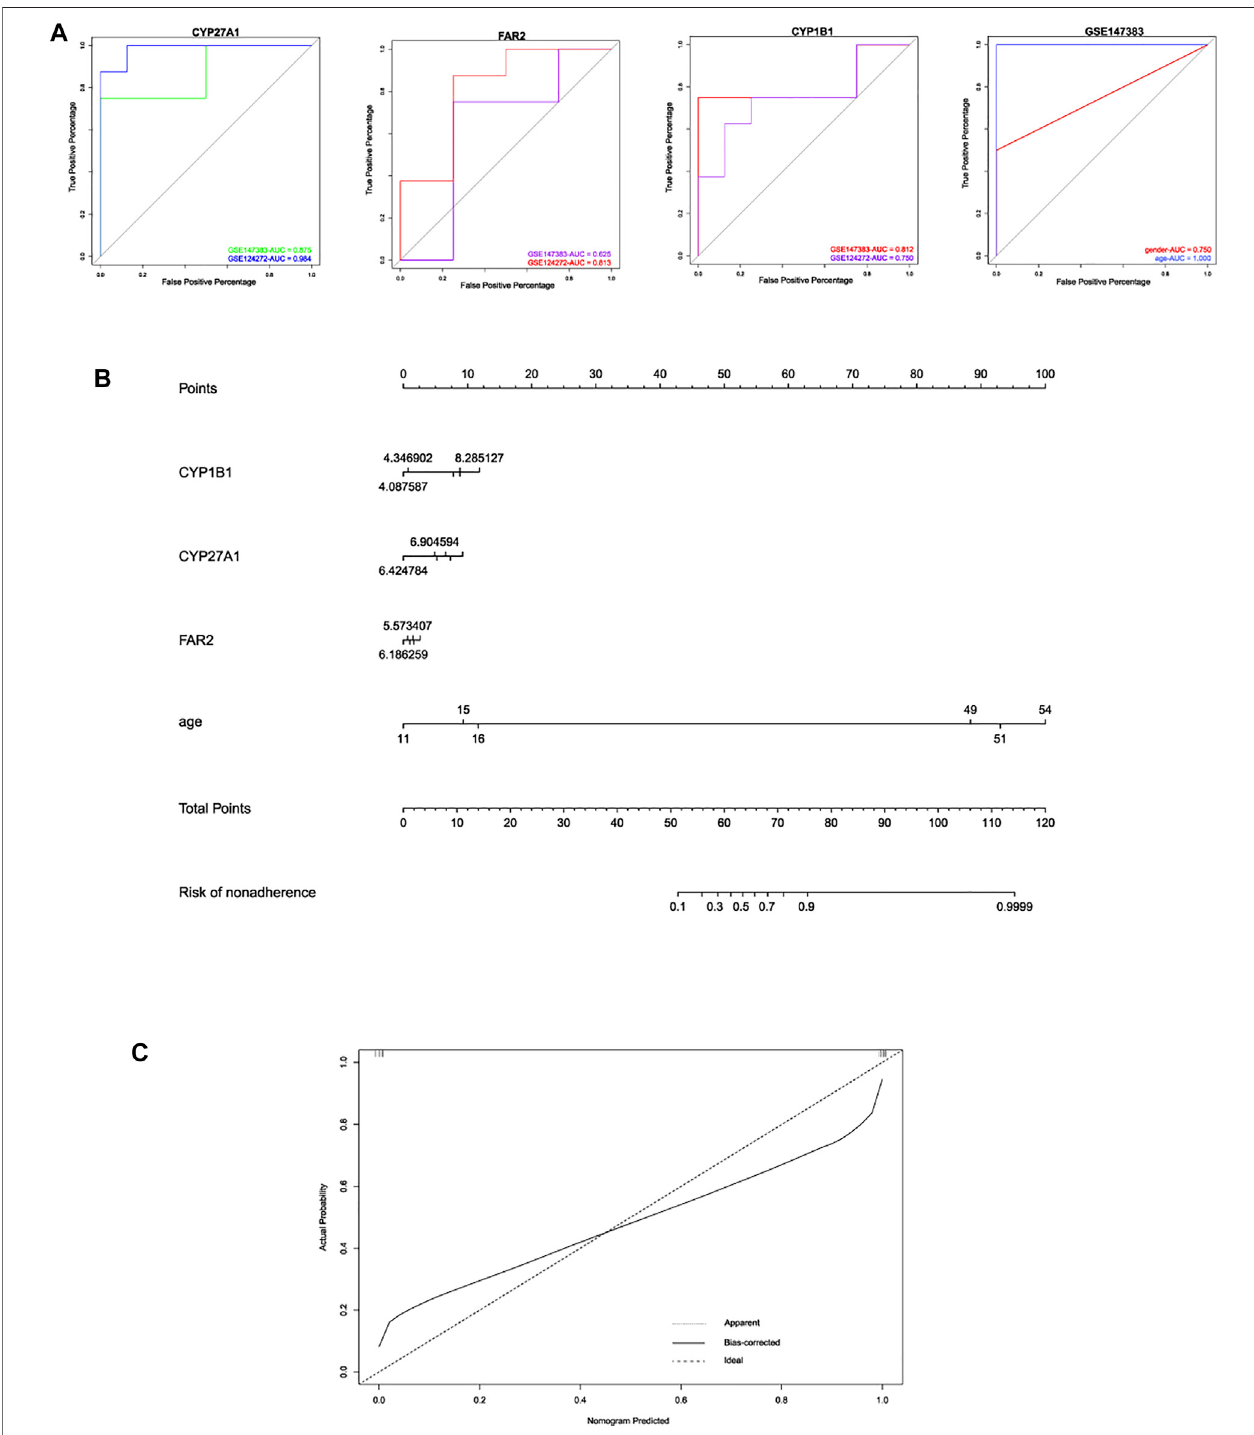
FIGURE 7 | (A) ROC curve analysis of these 3 hub LMRGs for predicting IDD in different datasets. (B) construction of nomogram model based on 3 hub LMRGs and clinical trait age. (C) calibration plot of nomogram for evaluating robustness of the prediction.